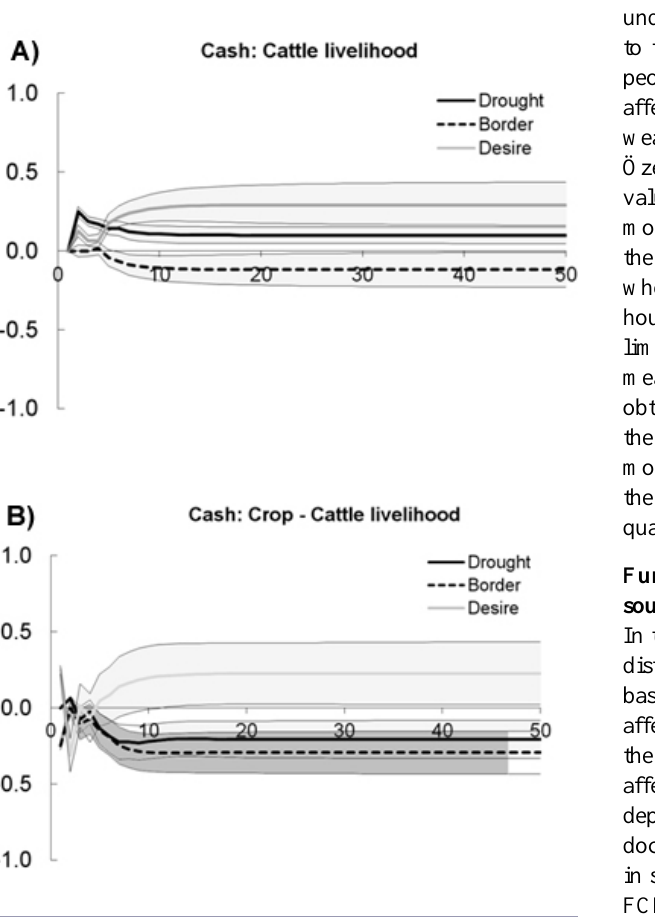
Fig. 7. Output of the Drought, Border, and Desirable scenarios relative to the Baseline scenario. The x-axis indicates the number of vector-matrix iterations; the length of the transition period, therefore, shows how many matrix multiplications are needed to take into account all of the feedbacks that exist within the system. The y-axis indicates the value of cash for cattle-based livelihoods (A) and cattle- crop-based livelihoods (B) relative to the Baseline scenario. Light gray bands represent the standard deviation of the ensemble scenario simulations in the sensitivity